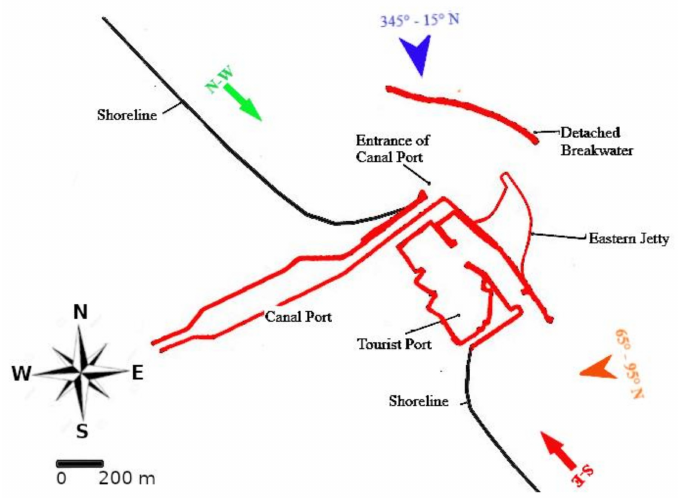
Figure 3. Schematic representation of a plan view of Pescara Harbour and near region. The blue and orange arrows indicate respectively the primary and secondary sector incoming waves. The green and red arrows indicate the longshore currents produced respectively by the primary and secondary sector incoming